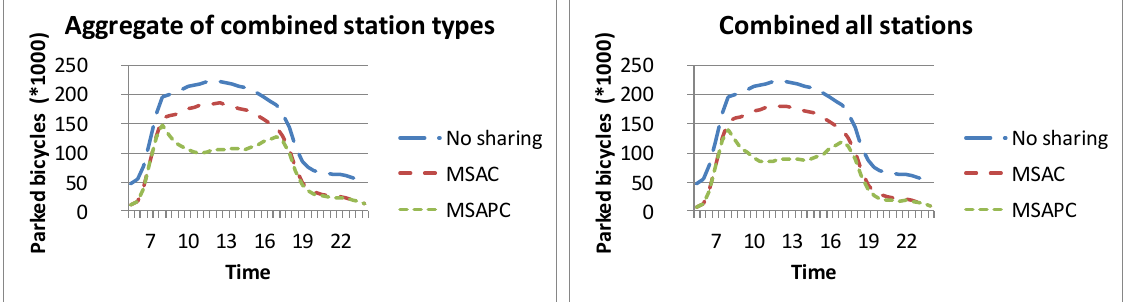
Figure 3. Distribution of parked bicycles over time for different sharing cases, whole